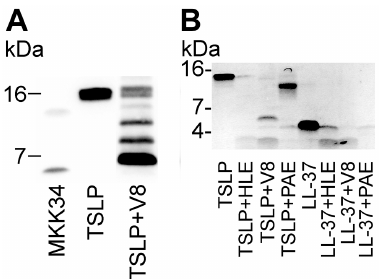
Figure 7. Enzymatic digestion of TSLP. ( A ) TSLP was digested with S. aureus V8 proteinase, and cleavage products were visualized by Western blot analysis using polyclonal antibodies against human TSLP. Products produced by V8 cleavage of TSLP revealed a major immunoreactive protein fragment at about 16 kDa. ( B ) TSLP and LL-37 were incubated with and without human neutrophil (leukocyte) elastase (HLE), S. aureus V8 proteinase or Pseudomonas aeruginosa elastase (PAE) and analyzed under non-reducing conditions by SDS-PAGE. From ref. [7].